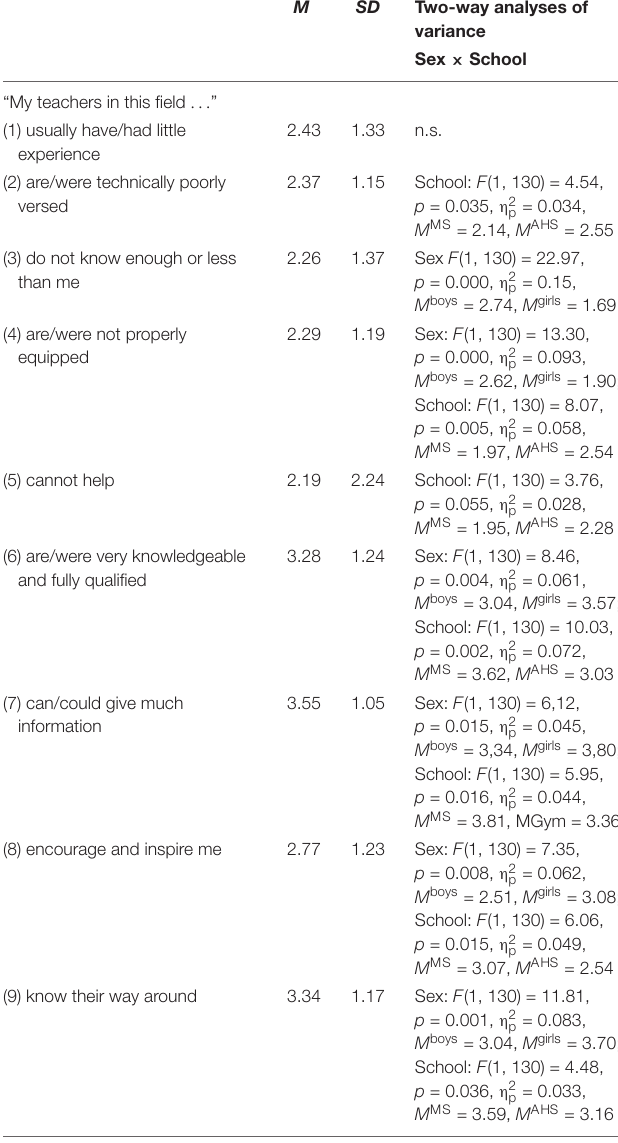
TABLE 6 | Perceived ICT competence of ICT